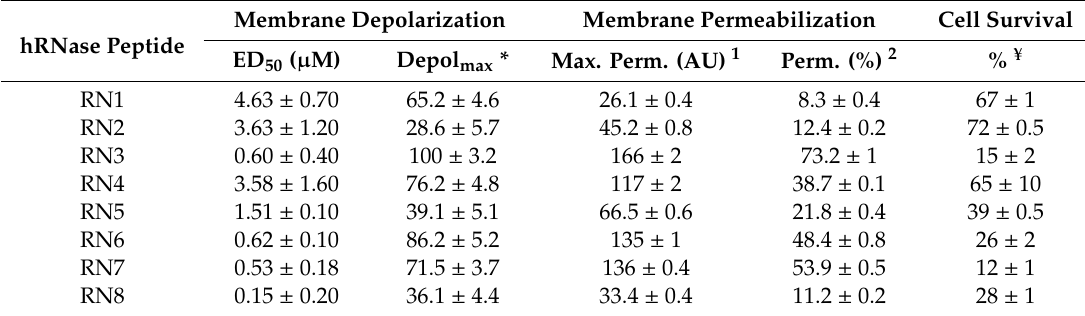
Table 3. Cell Membrane Depolarization, Permeabilization and Antimicrobial Activities of hRNases Peptides on C. albicans